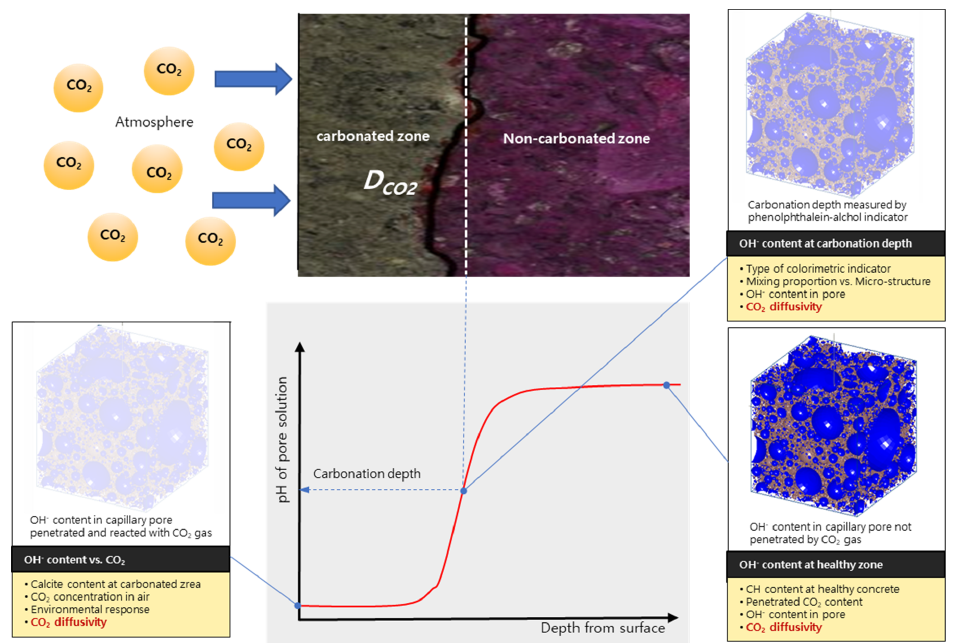
Figure 1. Importance of CO 2 di ff usivity as a decisive parameter for controlling carbonation rate of concrete. In this figure, the degree of carbonation of concrete is expressed as the hydroxyl concentration of cement hydrates. In the carbonated area, the pH of the pore solution is greatly reduced, and the rate depends on CO 2 concentration in the atmosphere as an environment response. For noncarbonated area, it has an original pH value. The border between the two areas can be determined by spraying a phenolphthalein-alcohol indicator and this also can be influenced by OH − content. The CO 2 di ff usivity is a material parameter that can make all these